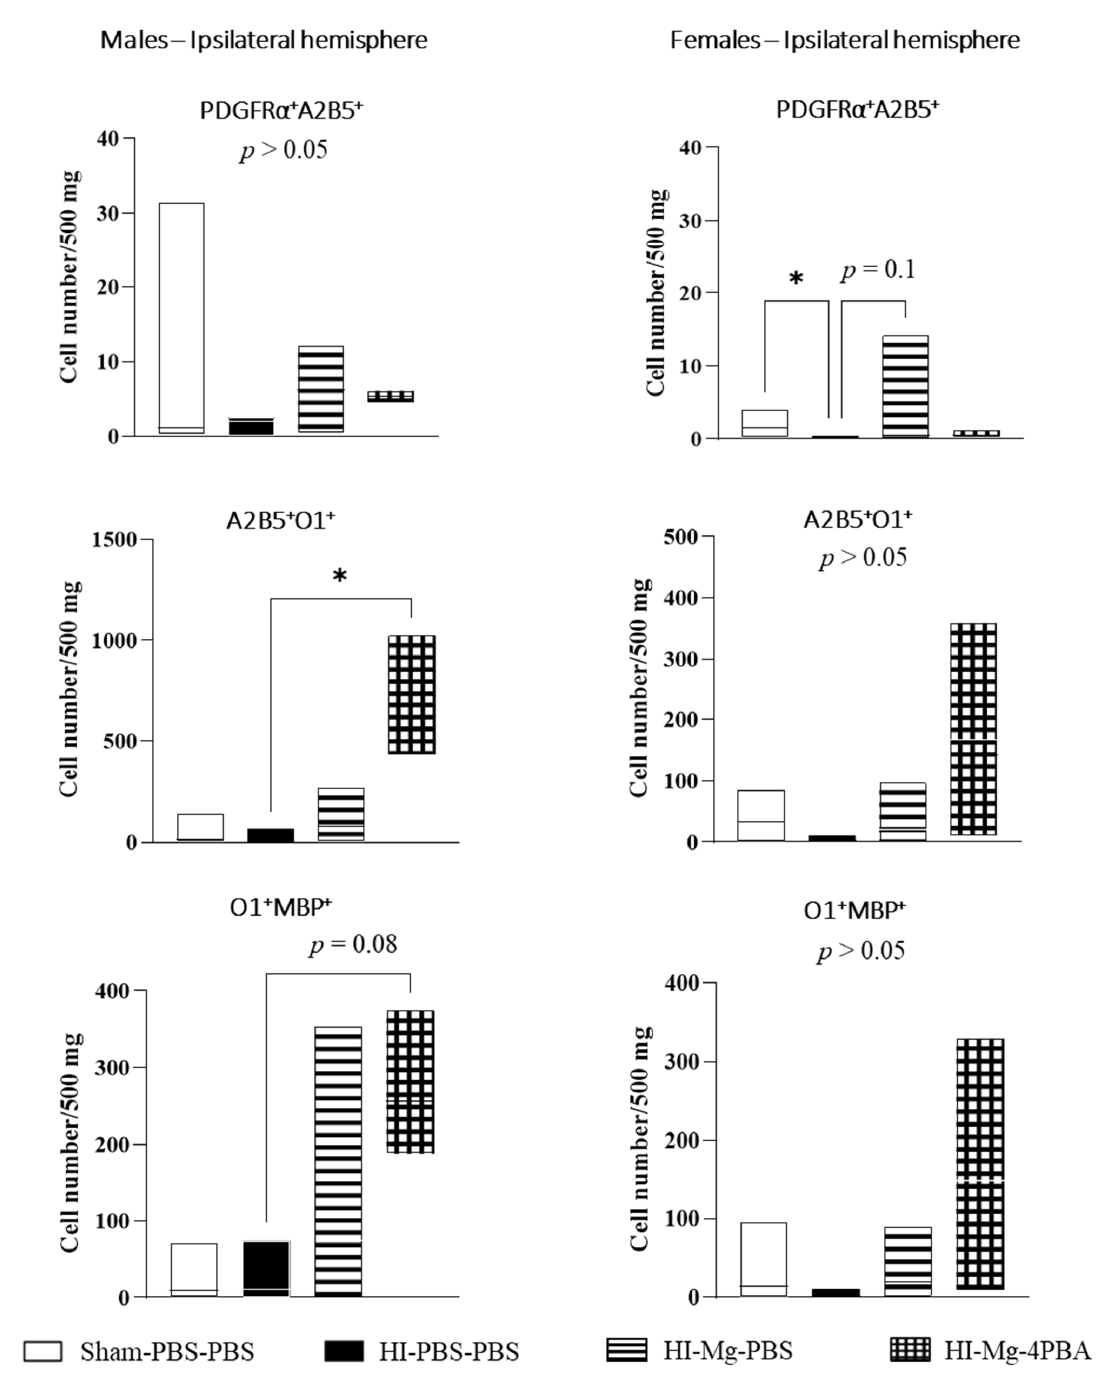
Figure 8. Effects of neonatal HI, MgSO 4 or of the MgSO 4 /4-PBA association on oligodendroglial populations in the ipsilateral hemisphere in adolescent male and female mice at P45. Oligodendroglial populations were sorted by flow cytometry. Oligodendroglial populations were defined as PDGFR α +A2B5+ early oligodendrocyte progenitor cells, A2B5+O1+ premyelinating oligodendrocytes and O1+MBP+ mature myelinating oligodendrocytes. Data are expressed as median with min and max values, n = 3–5 males and 4–8 females/group. The Kruskal–Wallis test was performed followed by Dunn’s post-test (* p < 0.05).